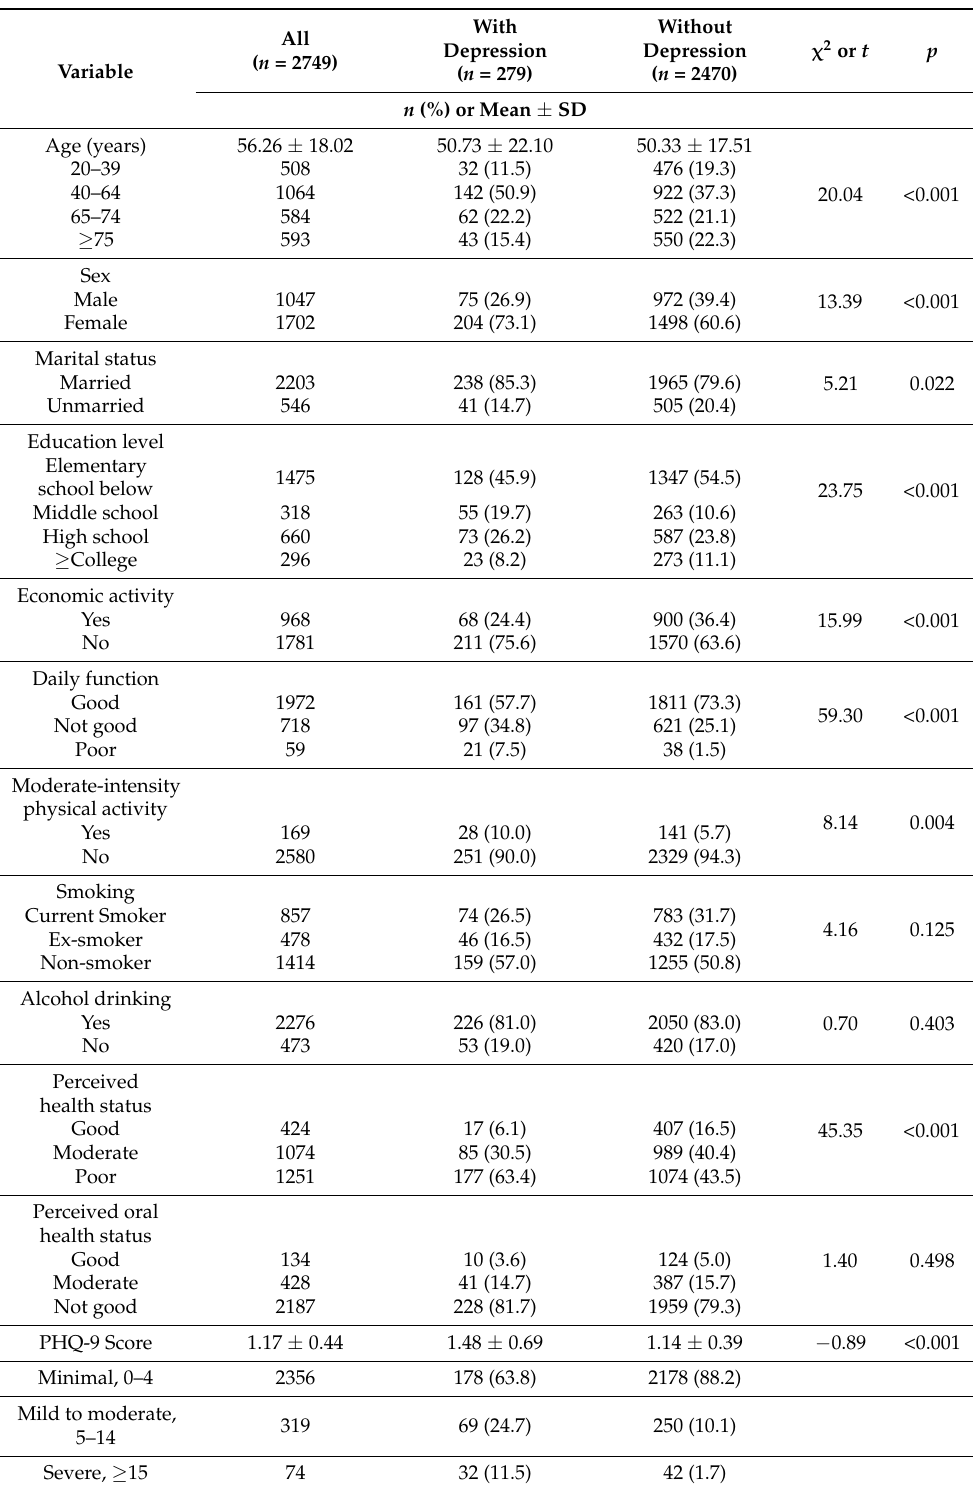
Table 1. General characteristics of subjects with and without depression ( N =